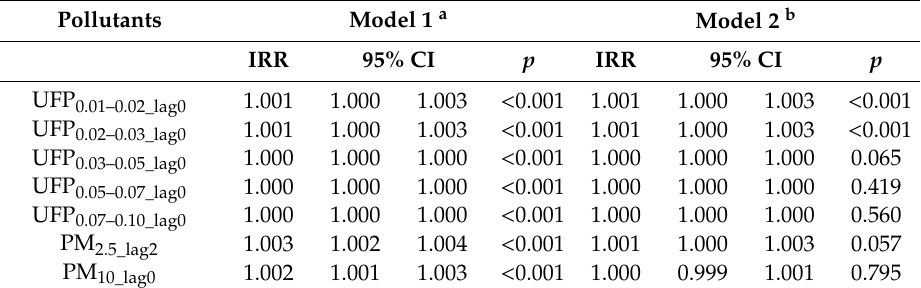
Table 4. Association between the daily number of consultations due to diabetes mellitus by the elderly populationandtheaverage24-hnumberconcentrationofUFP(number / cm 3 ); average24-hconcentration of PM 10 and PM 2.5 ( µ g / m 3 ) in the MOL, Slovenia between 1 January 2013 and 31 December 2017. Pollutants Model 1